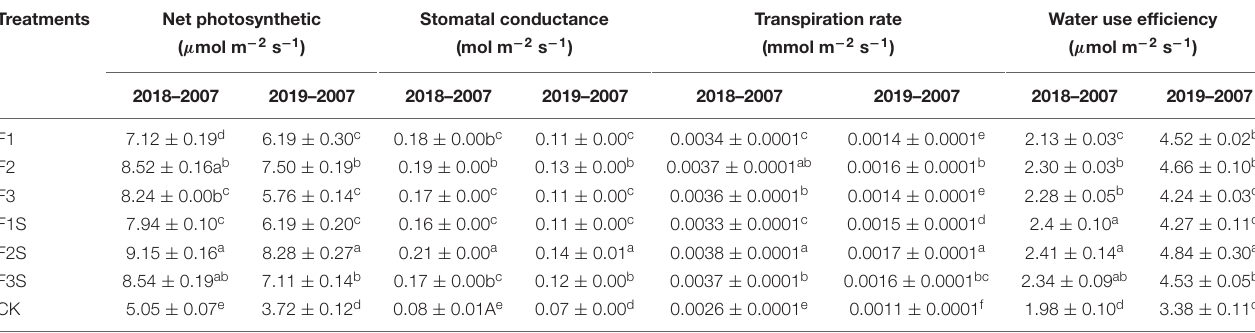
TABLE 2 | Net photosynthetic rate, stomatal conductance, transpiration rate, and water use efficiency of Pinus massoniana seedling needles under different treatments. Treatments Net